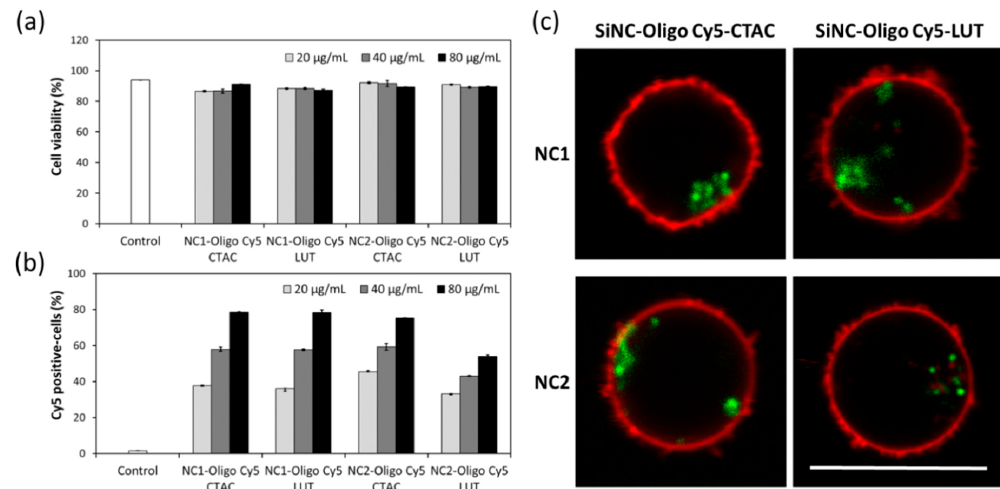
Figure 1. Cellular uptake study of SiNCs encapsulated Oligo Cy5 in CD8 + T-cells demonstrating—( a ) Cell viability, ( b ) Cy5 positive-cells, and ( c ) confocal laser scanning microscopy (cLSM) images of CD8 + T-cells after treatment with SiNCs encapsulated Oligo Cy5 for 17 h. The membrane was stained with CellMask ™ Orange (red). The SiNC was labeled with Oligo Cy5 (green). The scale bars represent 10 µm.